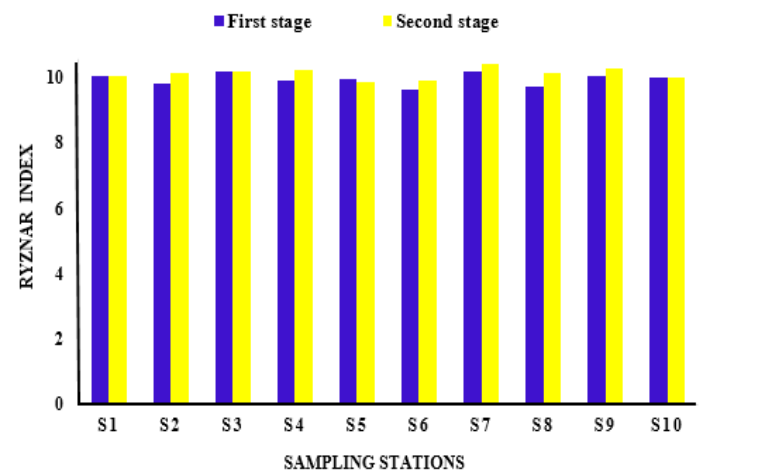
Figure 2. Comparison of RSI values for Meshginshahr’s drinking water distribution system